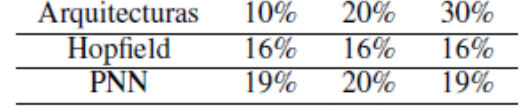
Fuente: Los Autores, (2018). Tabla 3: % de error de clasificación n con diferentes % de datos incompletos con clases